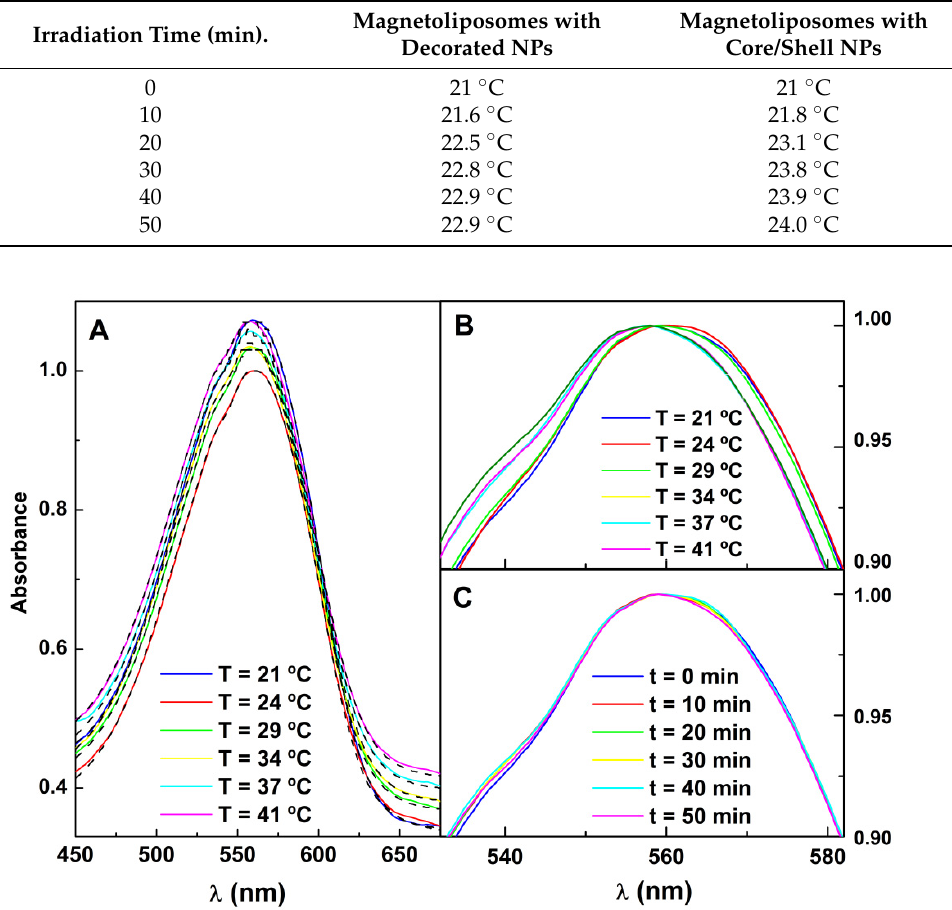
Figure 11. ( A ) Variation of absorption spectra of Nile Red in magnetoliposomes containing deco- rated nanoparticles, at different temperatures and fitting to the model (dashed curves). ( B ) Expan- sion of the normalized spectra of Figure A in the maxima region. ( C ) Expansion of the normalized spectra in the maxima region at several times of irradiation.